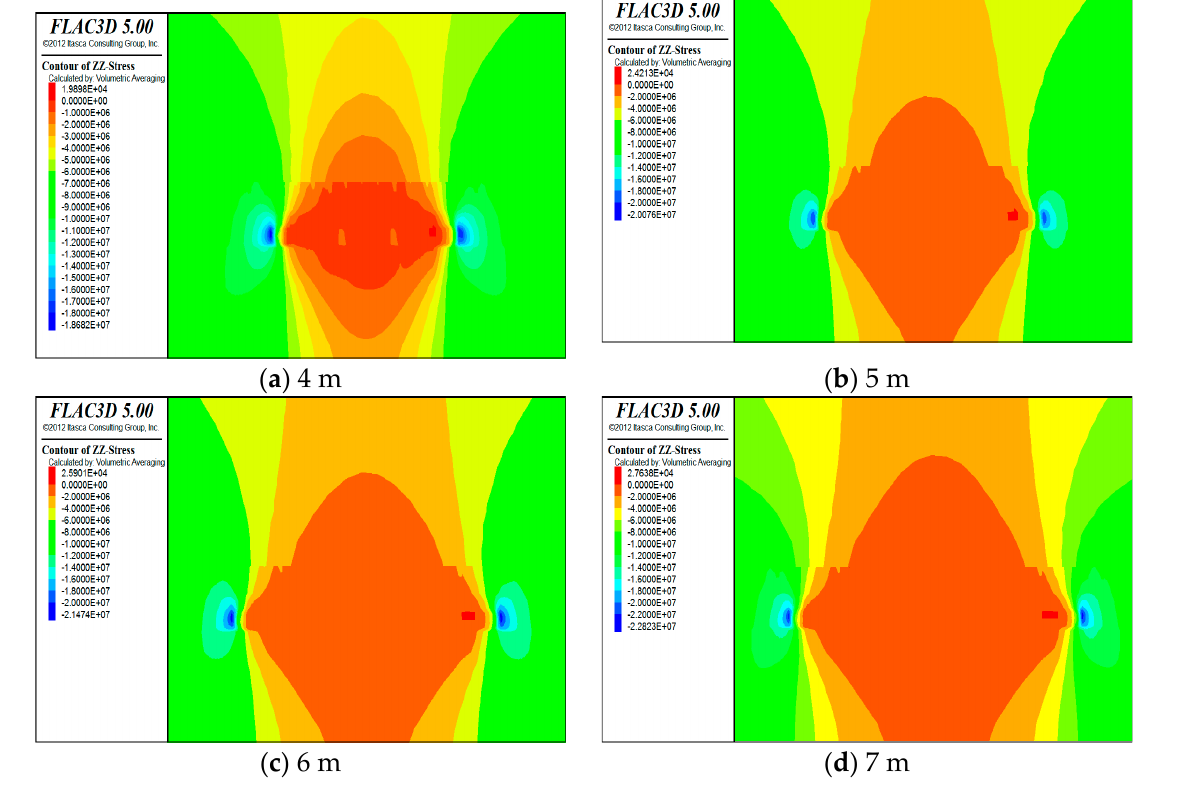
Figure 17. Cloud of vertical stress distribution for ( a ) 4 m, ( b ) 5 m, ( c ) 6 m, and ( d ) 7